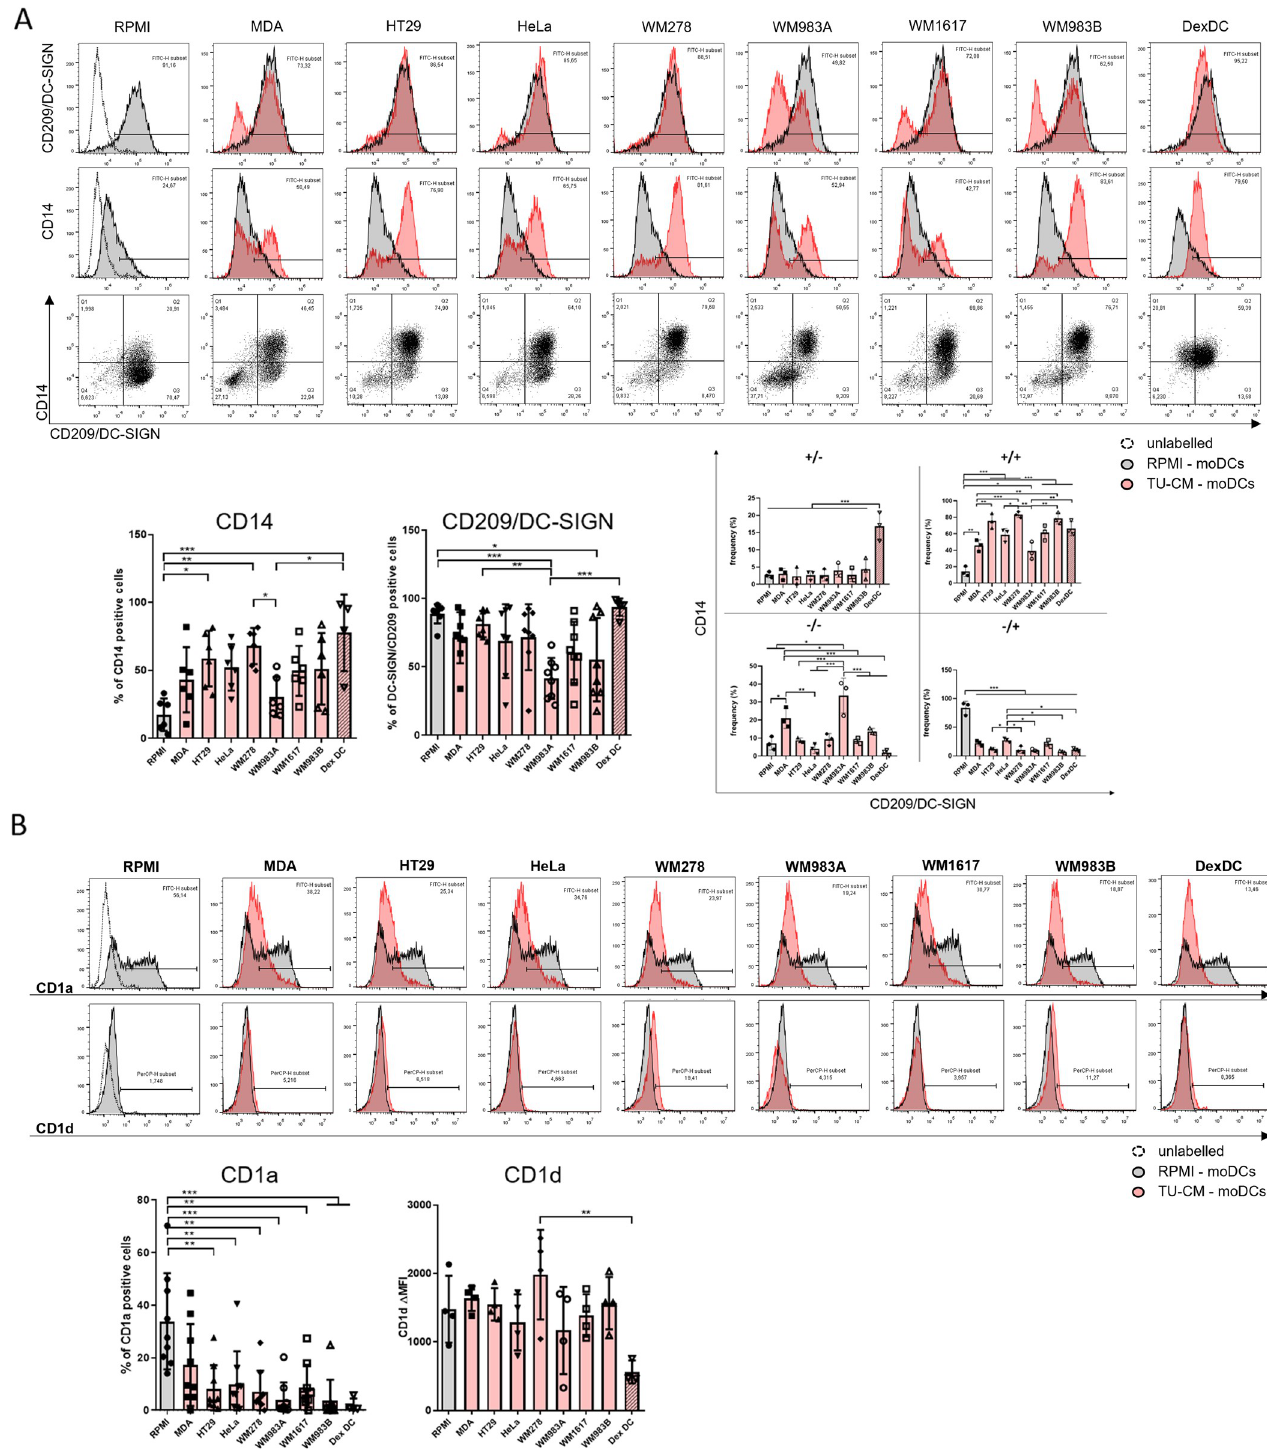
Fig 1. TU-CMs modify the phenotype of dendritic cells. CD14 + monocytes were cultured with 100 ng/ml IL-4, 80 ng/ml GM-CSF ± MDA-MB231-, HeLa-, HT29-, WM278-, WM1617-, WM983A- or WM983B-CM for four days. On day 4, the cell surface expression of (A) CD14 and DC-SIGN or (B) CD1a and CD1d were analyzed by flow cytometry. Figure A and B show the MFI (median fluorescence intensity) plus SD or the mean plus SD values of the populations positive for the measured surface molecules calculated from four independent experiments. Histograms or dot plots show one of the four independent experiments. Significance is indicated by � P < 0.05, �� P < 0.01, ��� P < 0.001.